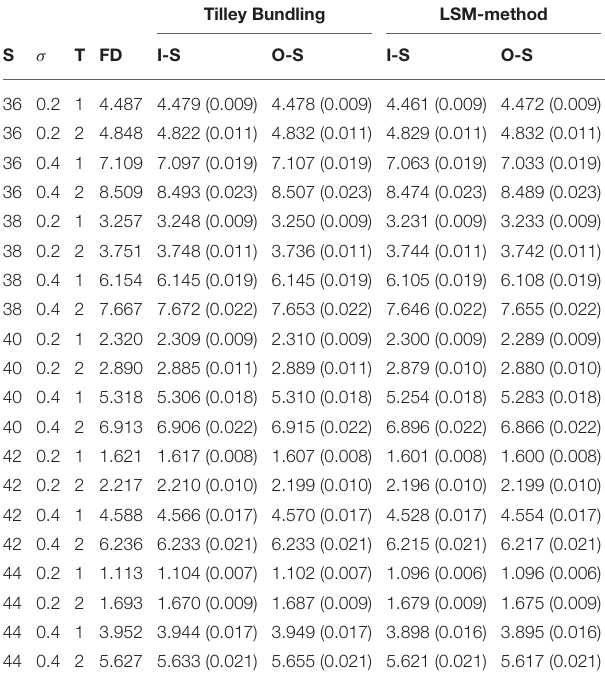
TABLE 1 | The value of an American Put stock option. The values in brackets show standard deviation. Tilley